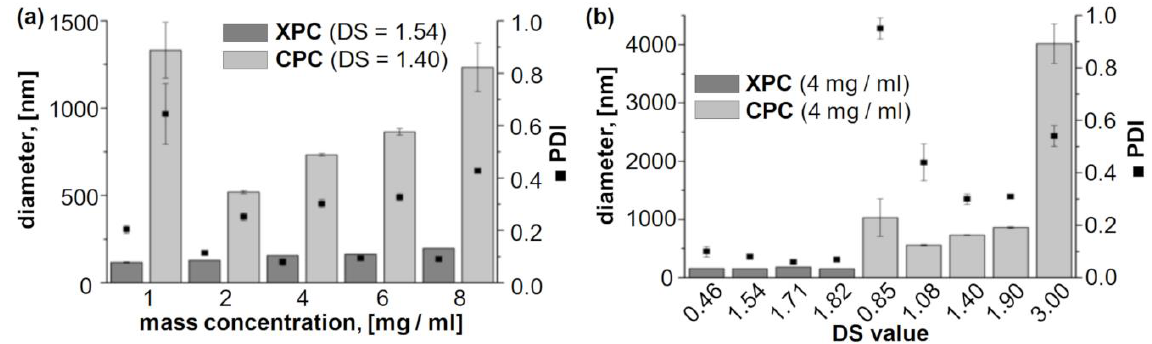
Figure 3. Particle sizes and polydispersity indices (PDI) of nanoparticles obtained by self-assembling of xylan phenyl carbonates (XPC) and cellulose phenyl carbonates (CPC) using a dialysis approach and ( a ) samples with similar degrees of substitution (DS) or ( b ) the same mass concentration for the starting polymer solution.